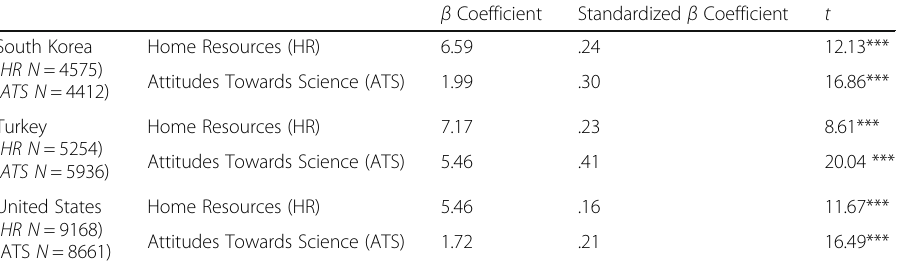
Table 6 Multiple regression results with home resources and attitudes towards science as predictors by countries